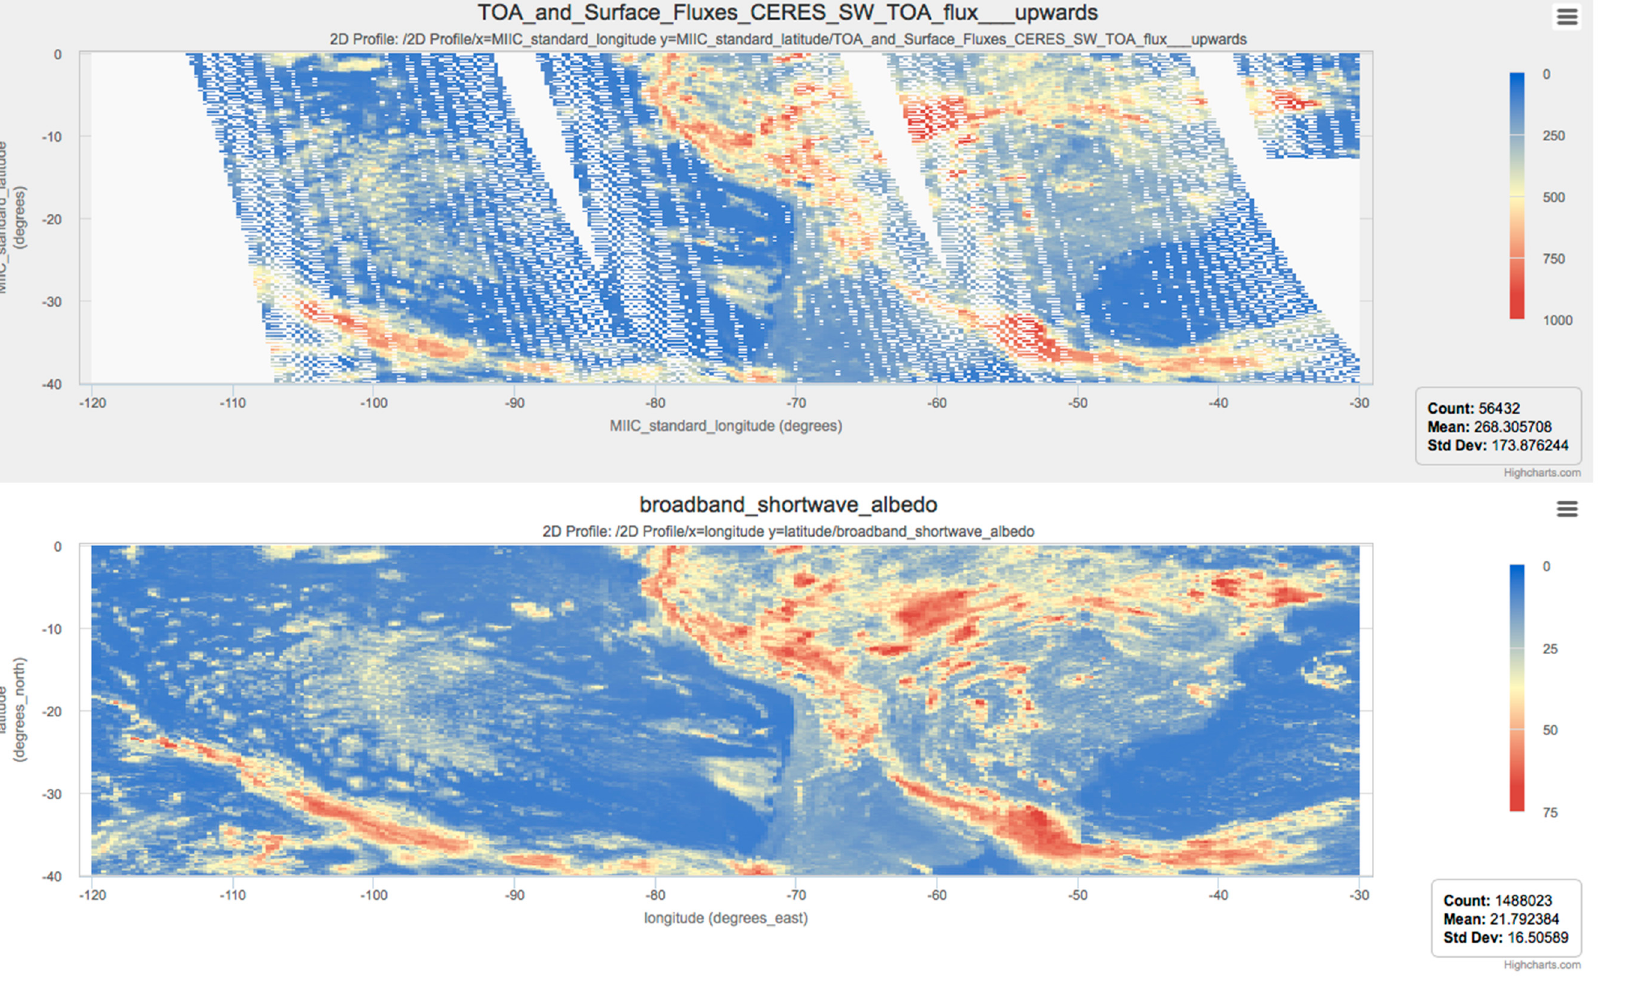
Figure 7. Single matched LEO-GEO event acquired from Aqua CERES ( top ) and GOES-East Imager ( bottom ), 30 January 2014 over South America.